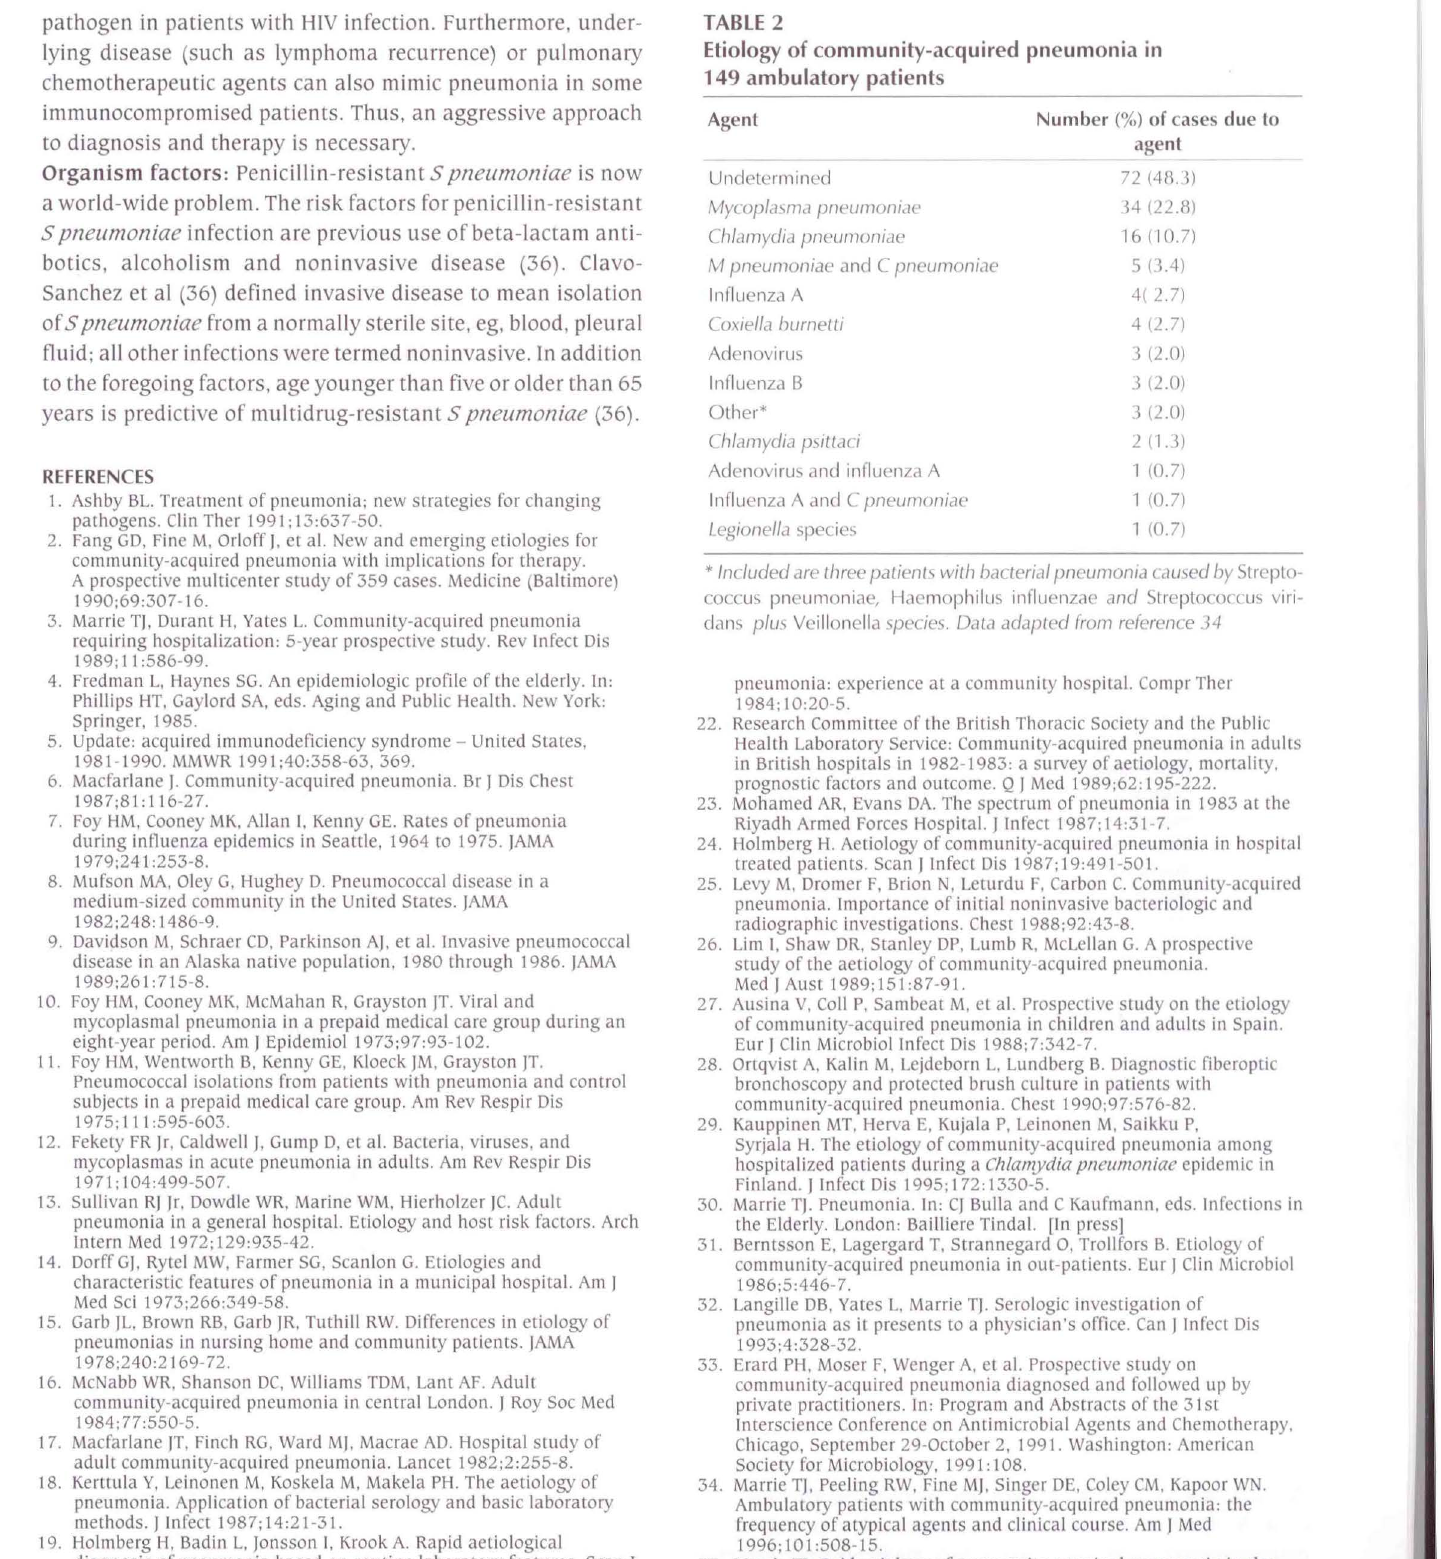
Etiology of community-acquired pneumonia in 149 ambulatory patients